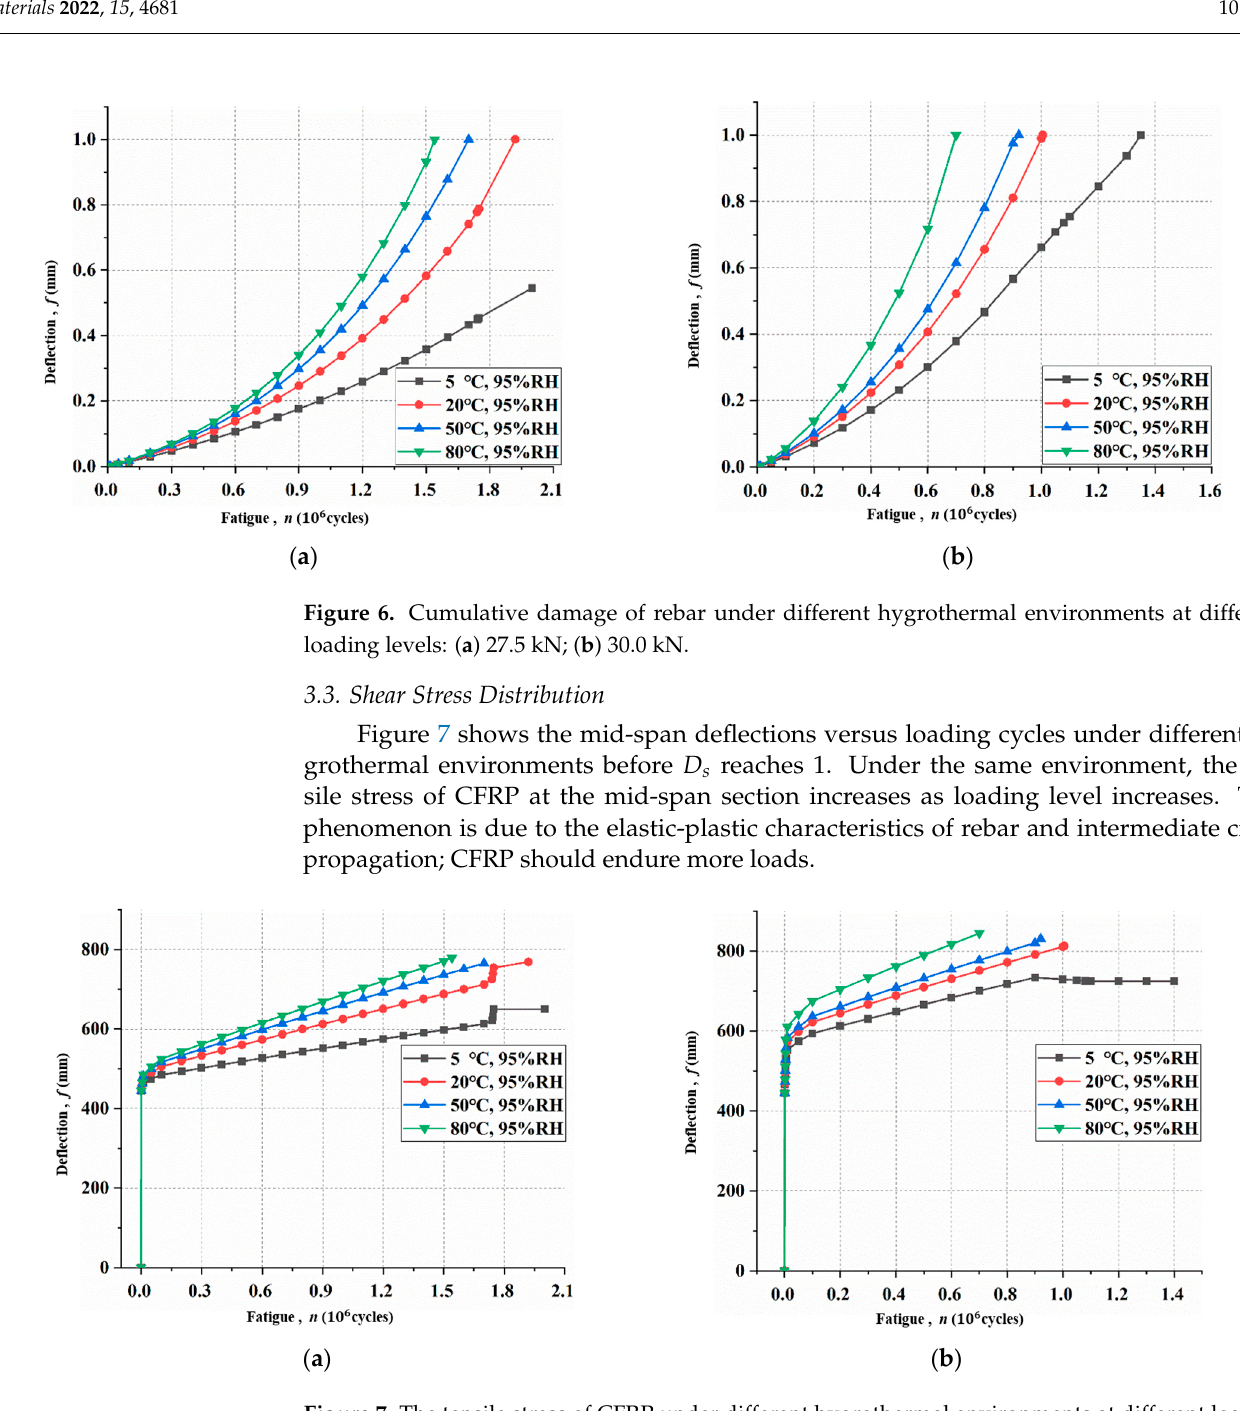
Table 4. Detailed test information and prediction results.